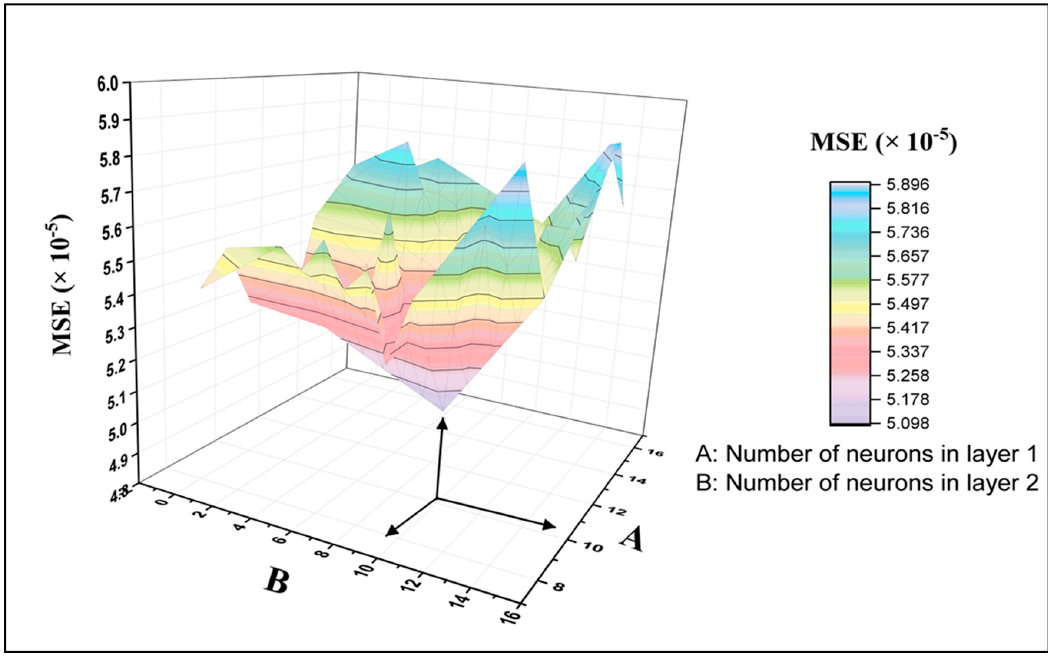
Figure 2. Neural networks’ performance-based MSE (the mean square error) utilizing di ff erent architectures: One and two hidden